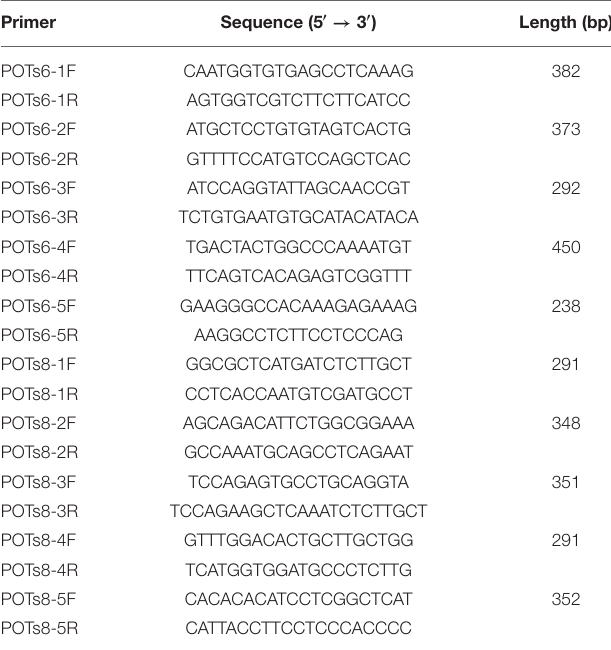
TABLE 1 | Primers of off-target